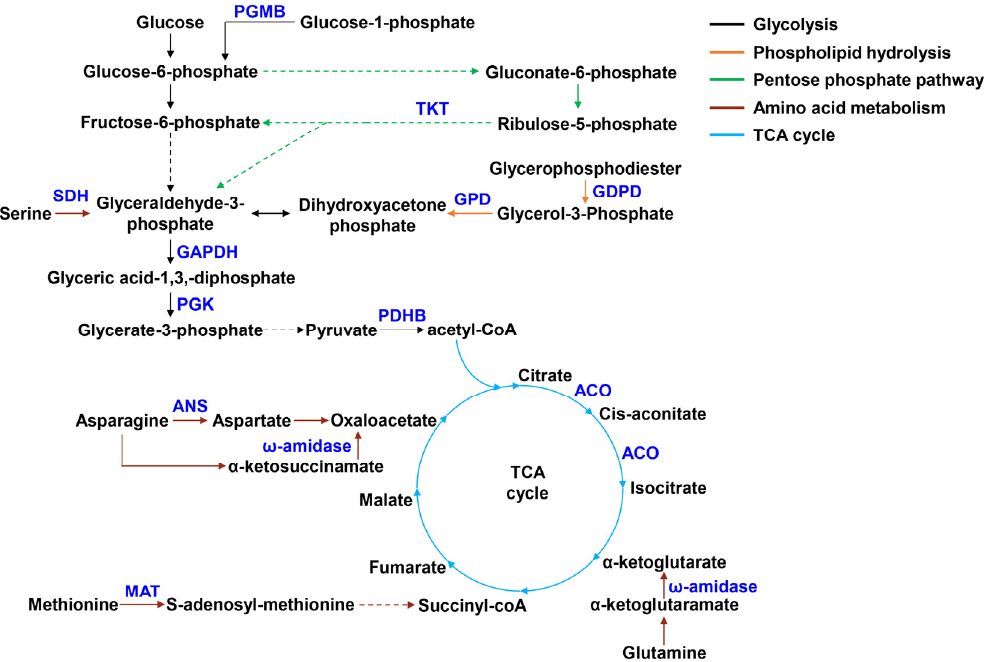
Figure 5. Function annotation results of DAPs in GO, KEGG and COG databases. ( A ) DAPs annotated in GO database. ( B ) DAPs annotated in KEGG pathway database. ( C ) DAPs annotated in COG database.